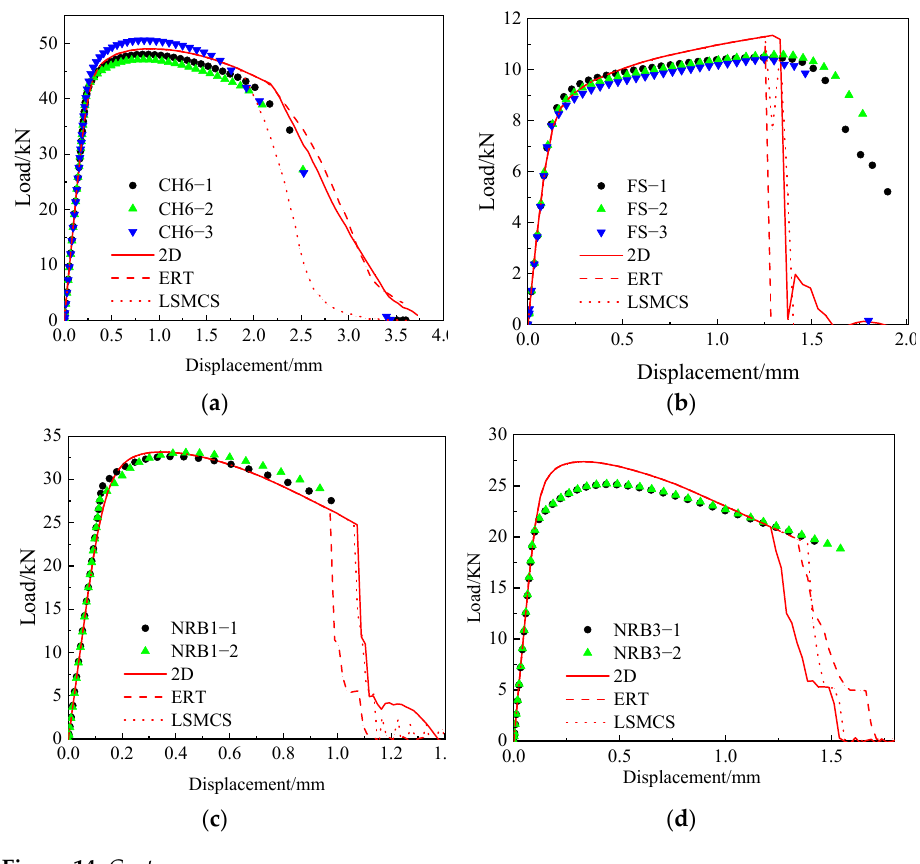
( e ) Figure 14. Comparison between finite element and experimental fracture: ( a ) CH6, ( b ) FS, ( c ) NRB1, ( d ) NRB3, and ( e ) NRB5. ( a ) ( b )